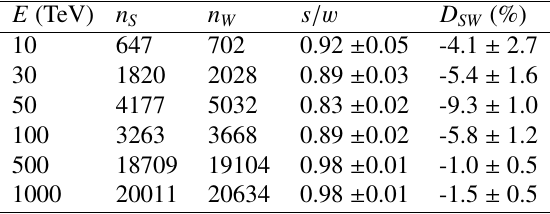
Figure 2: Spatial distribution (first row) and muon density ρ µ (second row) of summer muons (red) and winter muons (blue) crossing the surface (first column) and the detec- tor plane (second column) from primary protons with 100 TeV and θ = 30.